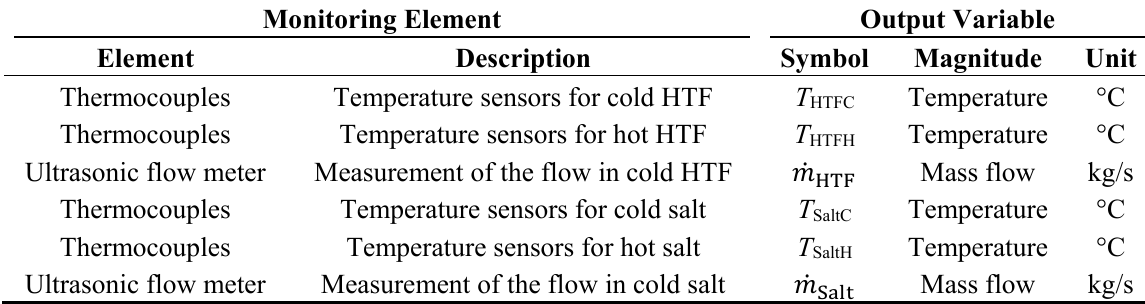
Table 2. Monitoring elements.